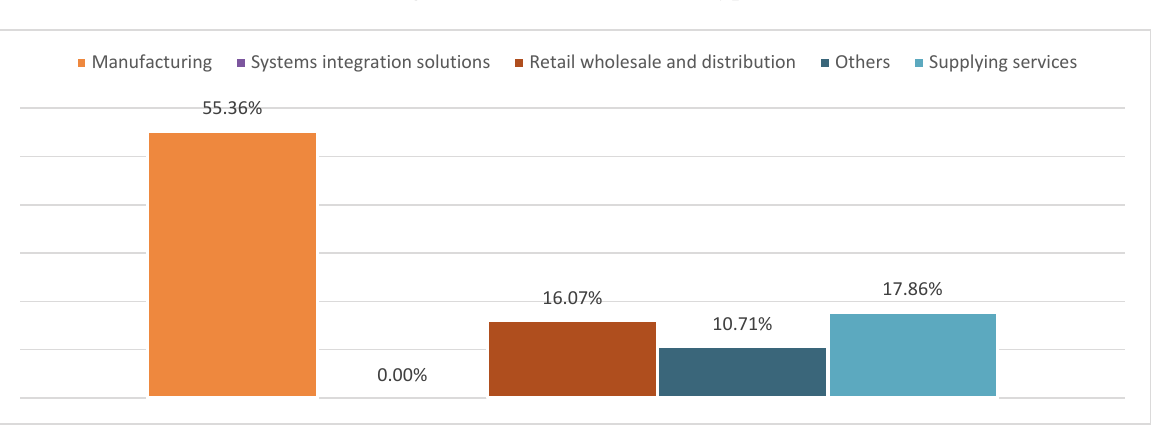
Fig. 4. Structure of business type